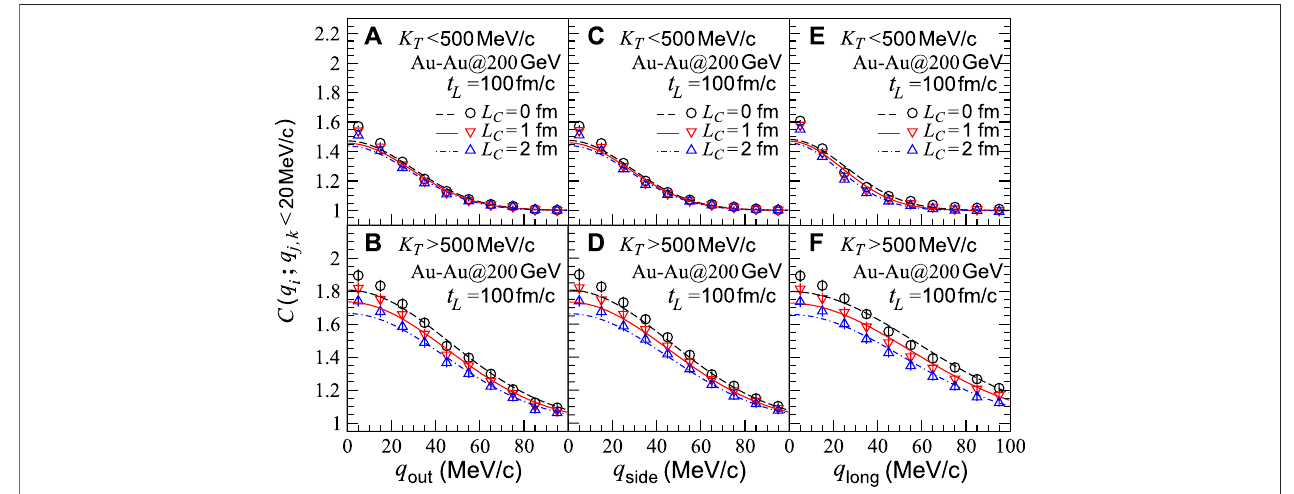
FIGURE 4 | Two-pion correlation functions with respect to relative momenta q i , j , k ( i , j , and k = out, side, and long) for sources in central Au-Au collisions at (cid:1)(cid:1)(cid:1)(cid:1) √ (cid:3) 200 GeV and with t s NN L = 100 fm/ c . Upper panels plot transverse momentum range K T and down-triangle symbols denote coherent emission lengths L C = 0, 1, and 2 fm, respectively. Lines are fi tted curves.